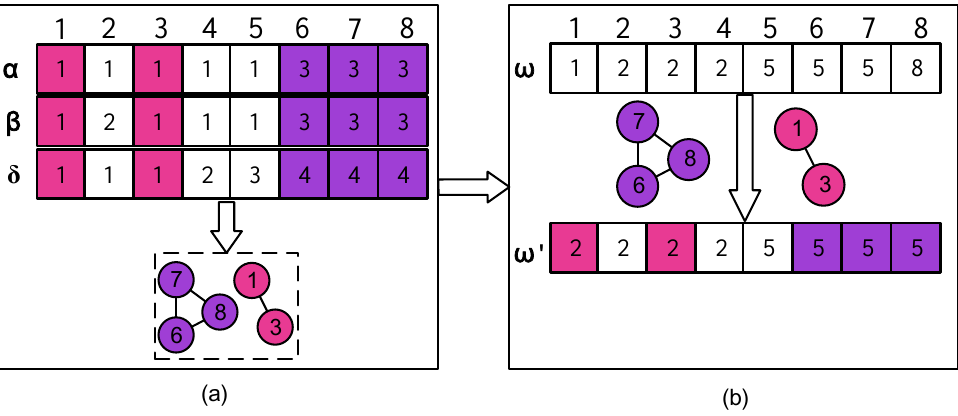
Figure 6. The improved hunting stage. ( a ) is the generation process of subc , and ( b ) is the process by which ω wolf hunt for prey based on subc